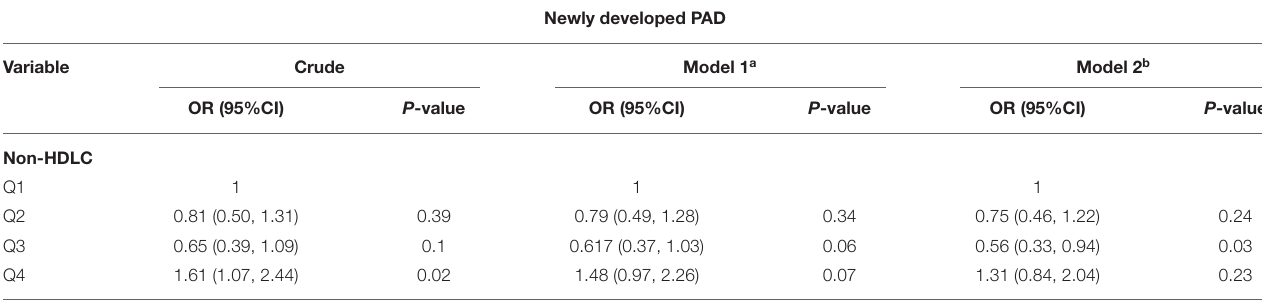
TABLE 3 | Odds ratios (OR) for newly developed peripheral artery disease (PAD) for non-high-density lipoprotein cholesterol (non-HDLC) burden. Newly developed PAD